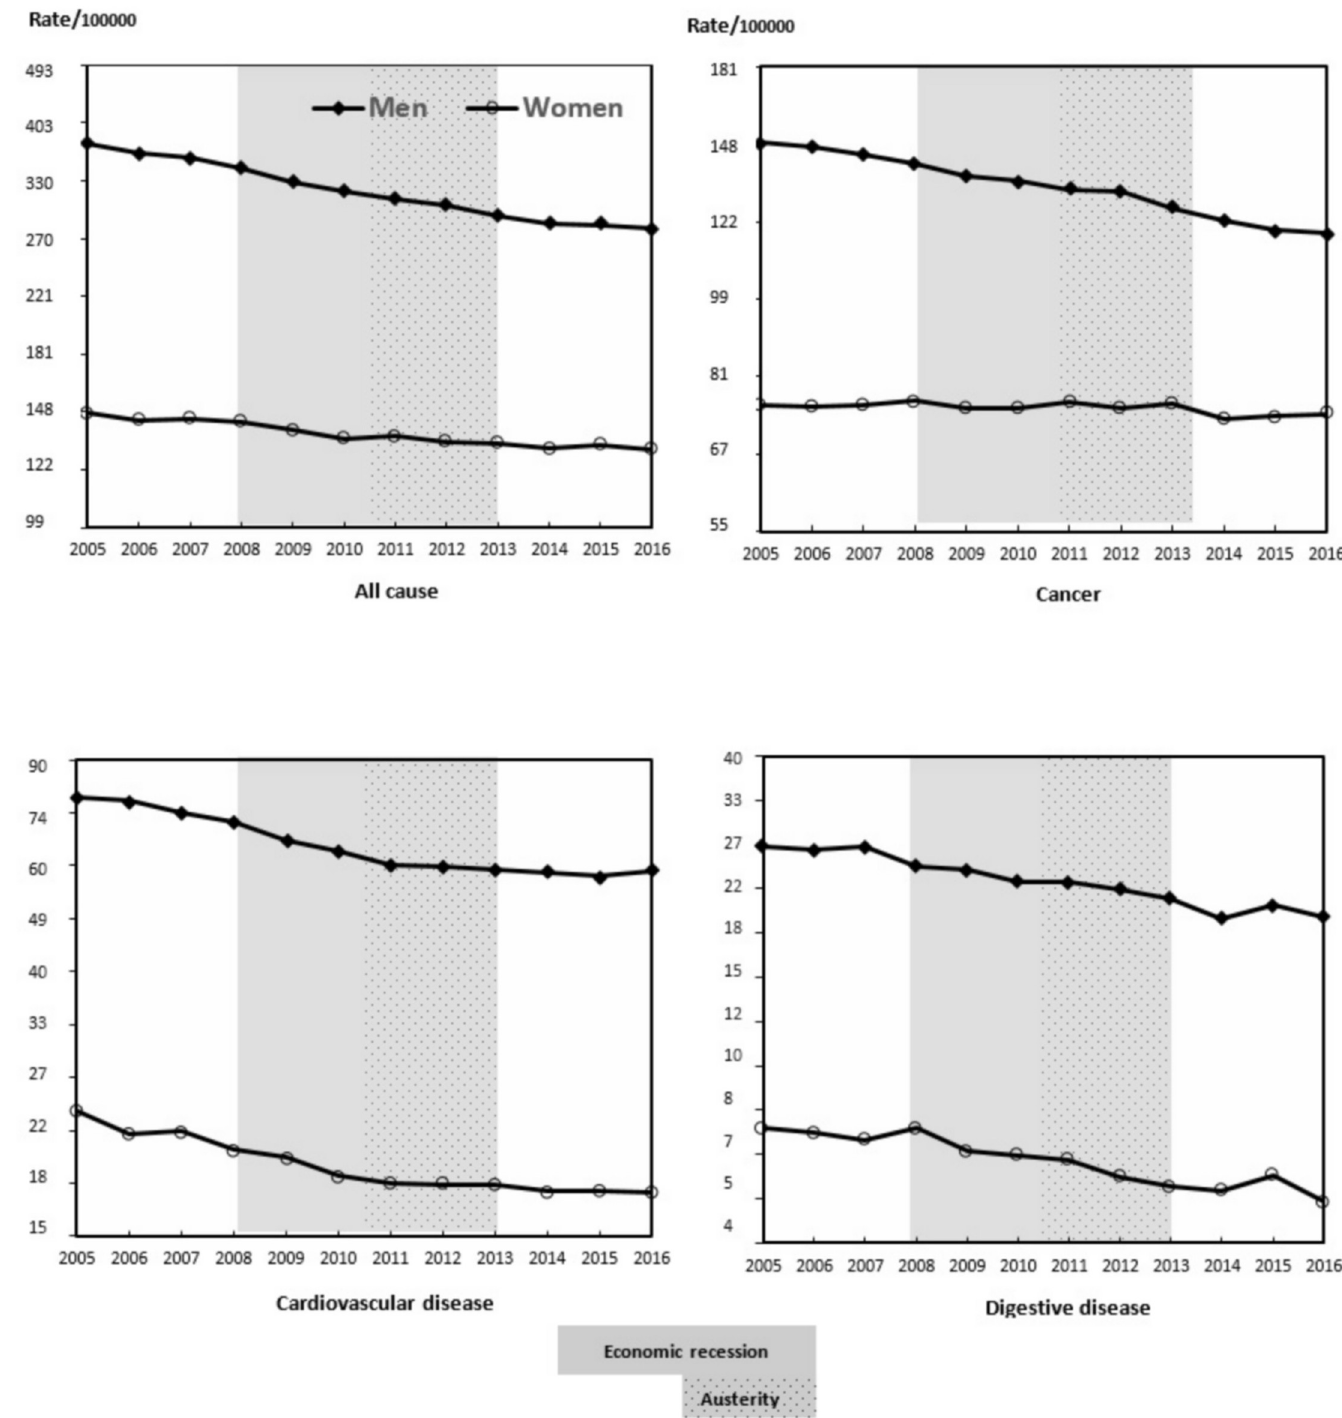
Fig 1. Mortality rate from all causes, cancer, cardiovascular and digestive diseases per 100,000 habitants. Men and women aged 15–64. Spain, 2005–2016.